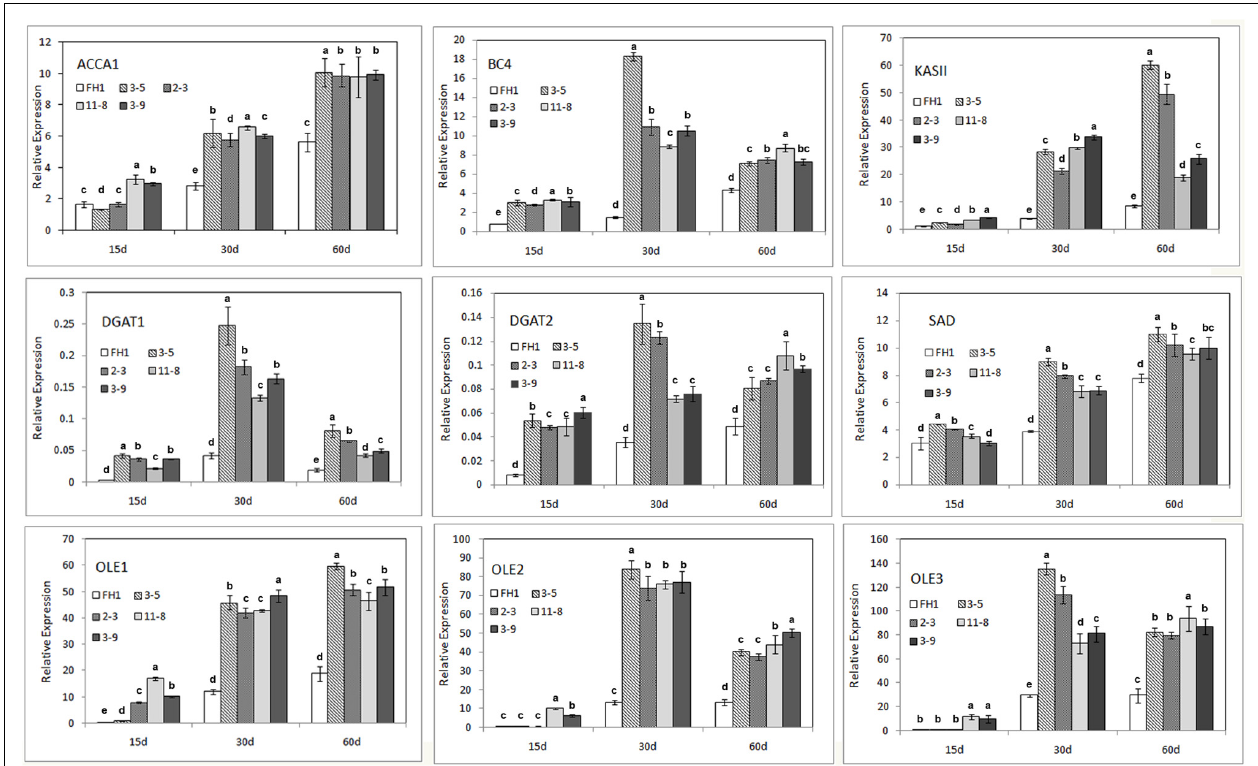
FIGURE 5 | Expression analysis of nine endogenous genes involved in FA synthesis and lipid accumulation in the developmental seeds of different transgenic peanut lines, as measured by qRT-PCR. One-way analysis of variance (ANOVA) for gene expression levels among different transgenic peanut lines and their control at different developmental stages was performed by SPSS software, and the significance of differences ( p < 0.05) was assessed by Duncan’s new multiple range test with values with different letters being significantly different. FH1, untransformed control. Relative transcript levels were quantified by comparison to that of peanut actin7 as a reference